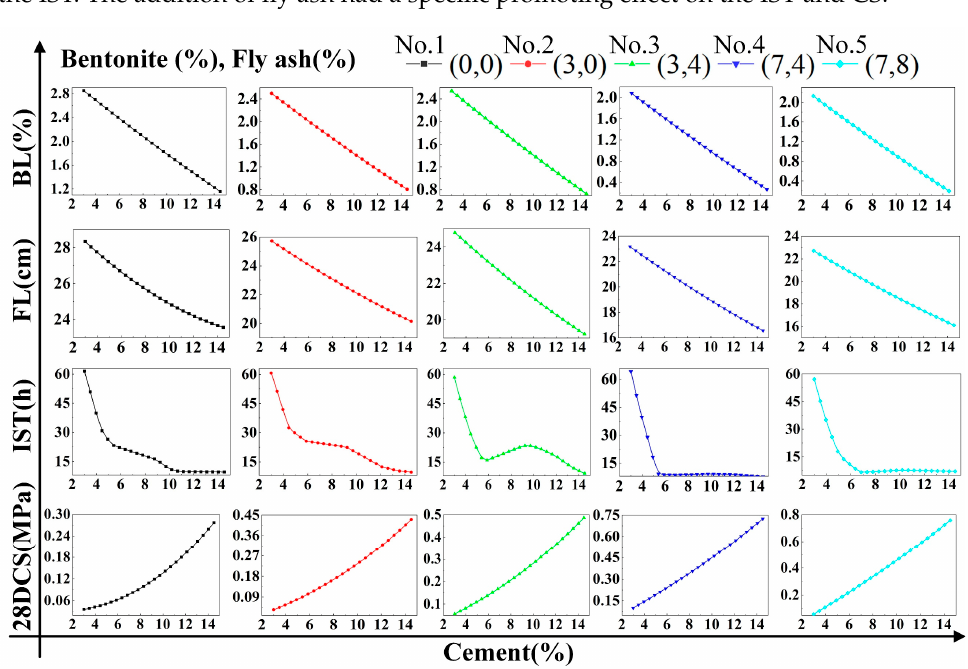
Figure 20. Performances of CS predicted models. ( a ) 7D ( b ) 14D ( c ) 28D.